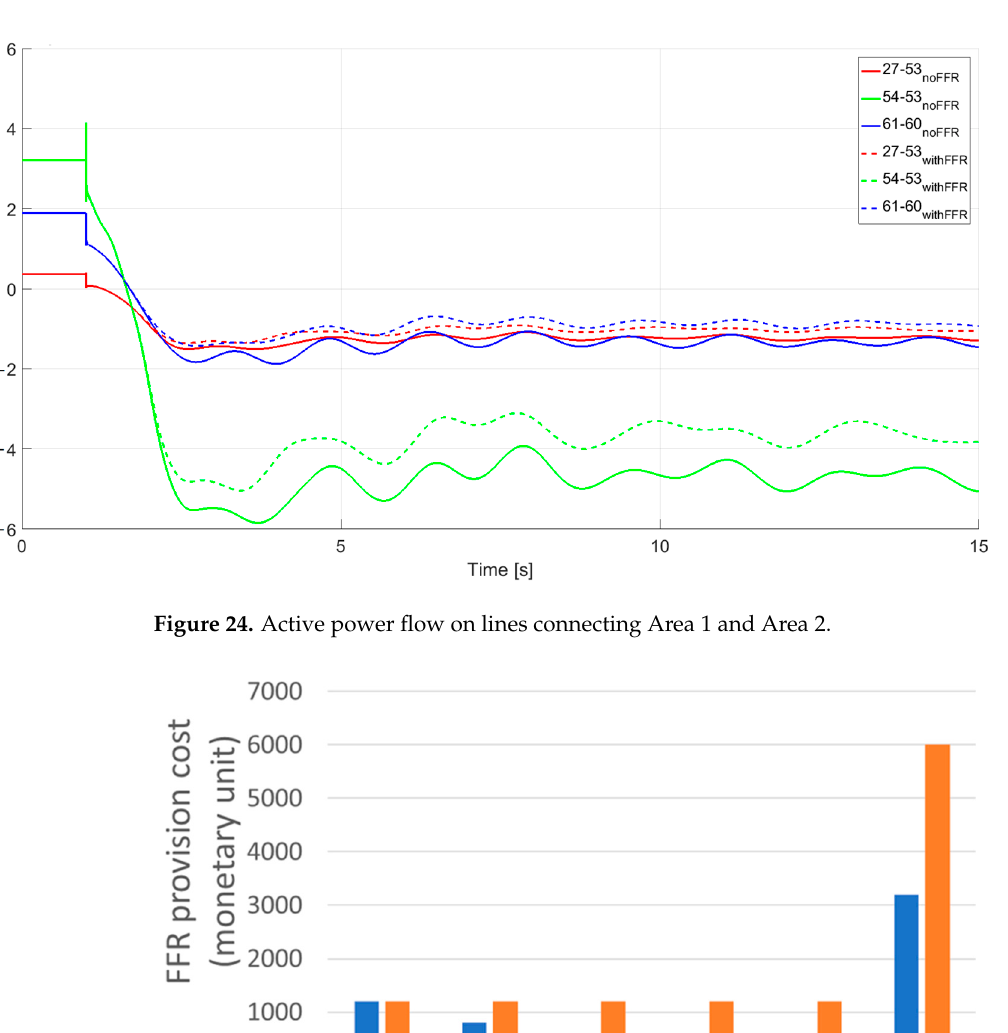
Figure 23. FFR in different areas.